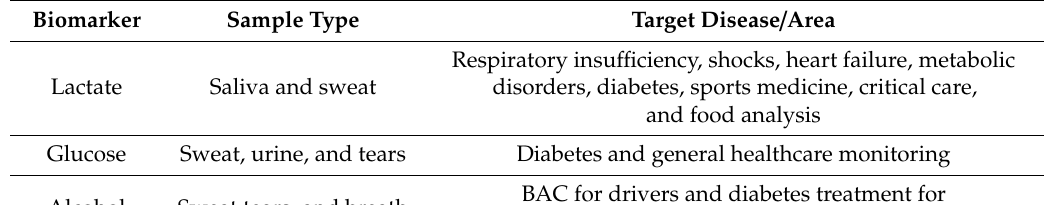
Table 6. Summary of Commonly Repeated Analytes.